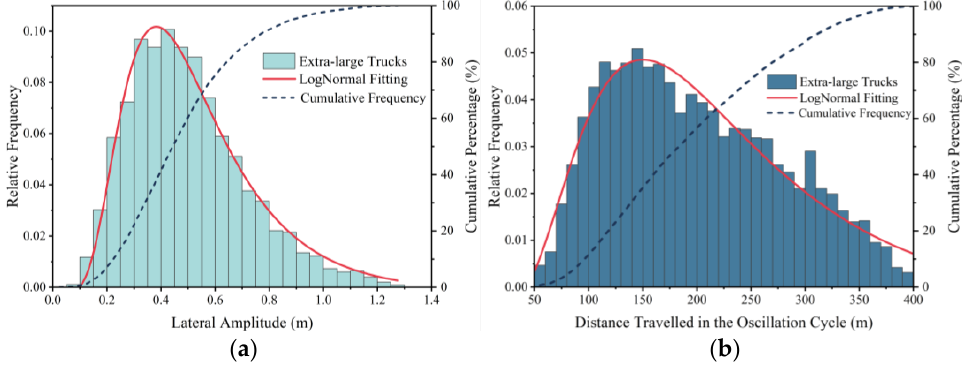
Figure 9. ( a ) Distribution of the LA for extra-large trucks; ( b ) Distribution of the DTOC for extra- large trucks. Table 5. The coefficients of LogNormal and eigenvalues of the trajectory oscillation